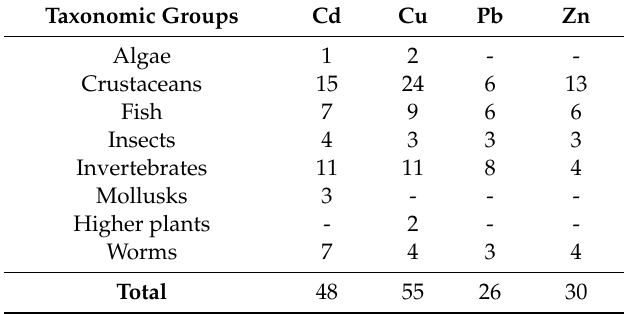
Figure 1. Donut charts representing the toxicity data for Korean resident organisms (inside donut chart) among all of the data obtained (outside donut chart) . Table 4. Species compositions that comprise the toxicity data for the heavy metals in this study .